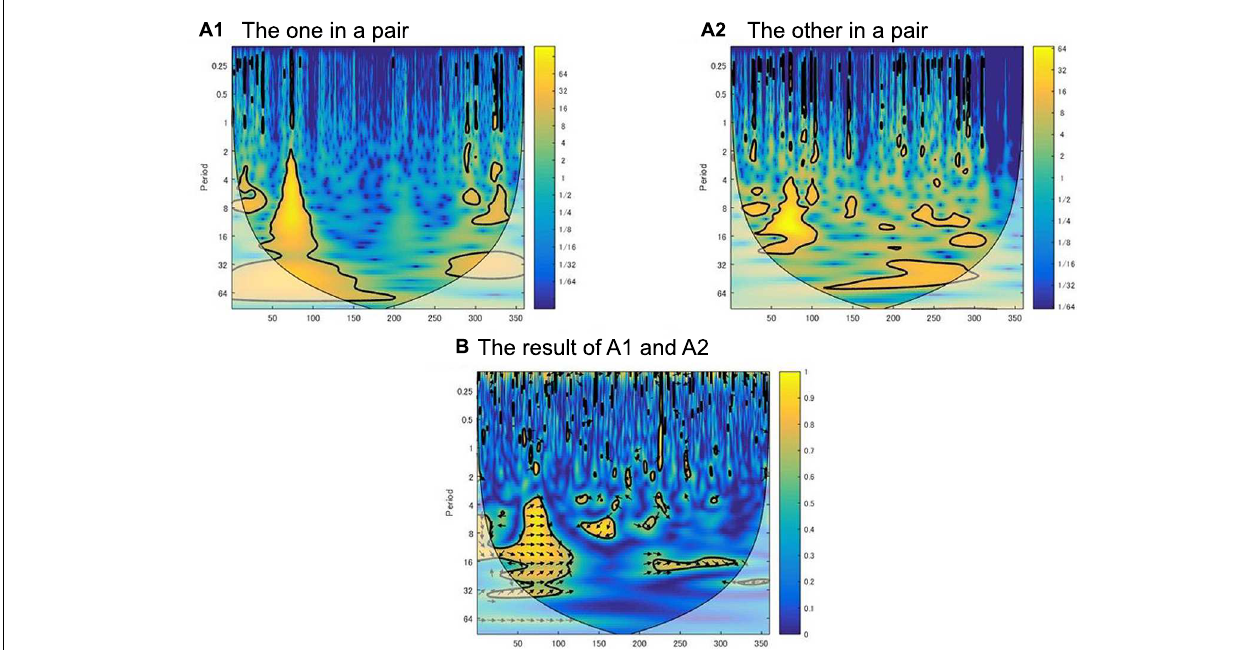
FIGURE 2 | Example of interpersonal coordination in time-frequency plane. Two images of wavelet power (A1,A2) and one of the cross-wavelet coherence (B) of A1 and A2 are shown. The time line is represented on the x -axis (360 s) and each frequency component is represented on the y -axis, as an inverted period (e.g., 0.25 period is 4 Hz). The magnitude of wavelet power and wavelet coherence is represented by color. (B) , The relative phase at a given frequency and time point is denoted by the orientation of the arrow: the right arrow indicates in-phase synchronization, the left arrow indicates anti-phase synchronization, and the downward arrow indicates no synchronization. The average value of these variables at a given frequency was extracted from these plots to analyze the coherence and relative phase. However, the cone of influence (COI) area that is shown as a lighter shade is not included in the